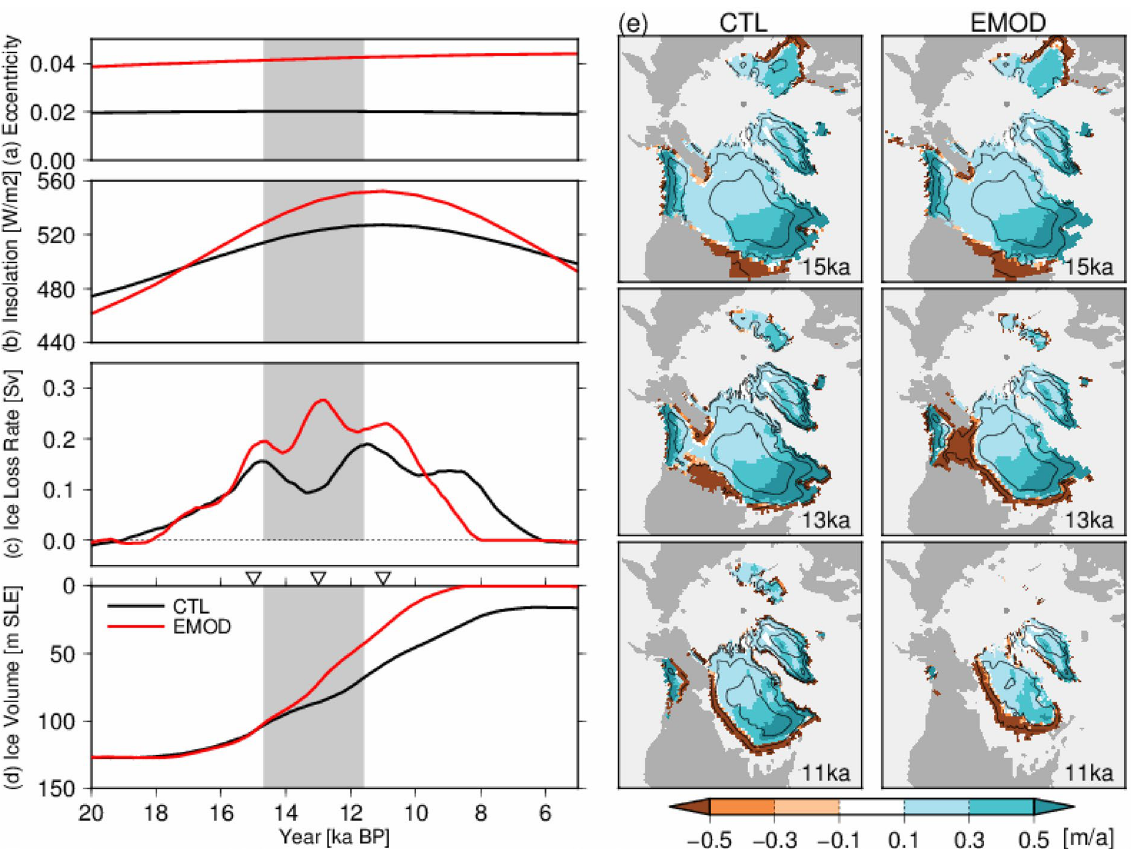
Figure 4. Experimental design and results of the ice sheet model experiments. The black lines indicate the results of simulation of the last 400,000 years 38 . The grey shaded area corresponds to the last deglaciation from the BA period to onset of the Holocene (14.7 to 11.6 ka BP), as in Fig. 1. The red lines indicate the experimental design and results of the EMOD (Eccentricity MODified) experiment, where orbital eccentricity was changed to that of T2 at the time of 20 ka BP. ( a ) Orbital eccentricity and ( b ) summer solstice insolation at 65° N using each eccentricity of ( a ). ( c ) Simulated Northern Hemisphere ice loss rate, calculated based on the ice volumes changes in 1000-year intervals. ( d ) Volume of Northern Hemisphere ice sheets, calculated based on the sum of the North American and Eurasian ice sheets. Here, the volumes of the ice sheets (m 3 ) were divided by 4.0 × 10 14 to determine the sea level equivalent 58 . Triangles show the time slices of ( e ). ( e ) Map showing shapes and surface mass balances of ice sheets at three different time slices. Colours indicate the surface mass balance in metres per year. The maps were generated using GMT version 4.5.9 (URL: https:// www. soest. hawaii. edu/